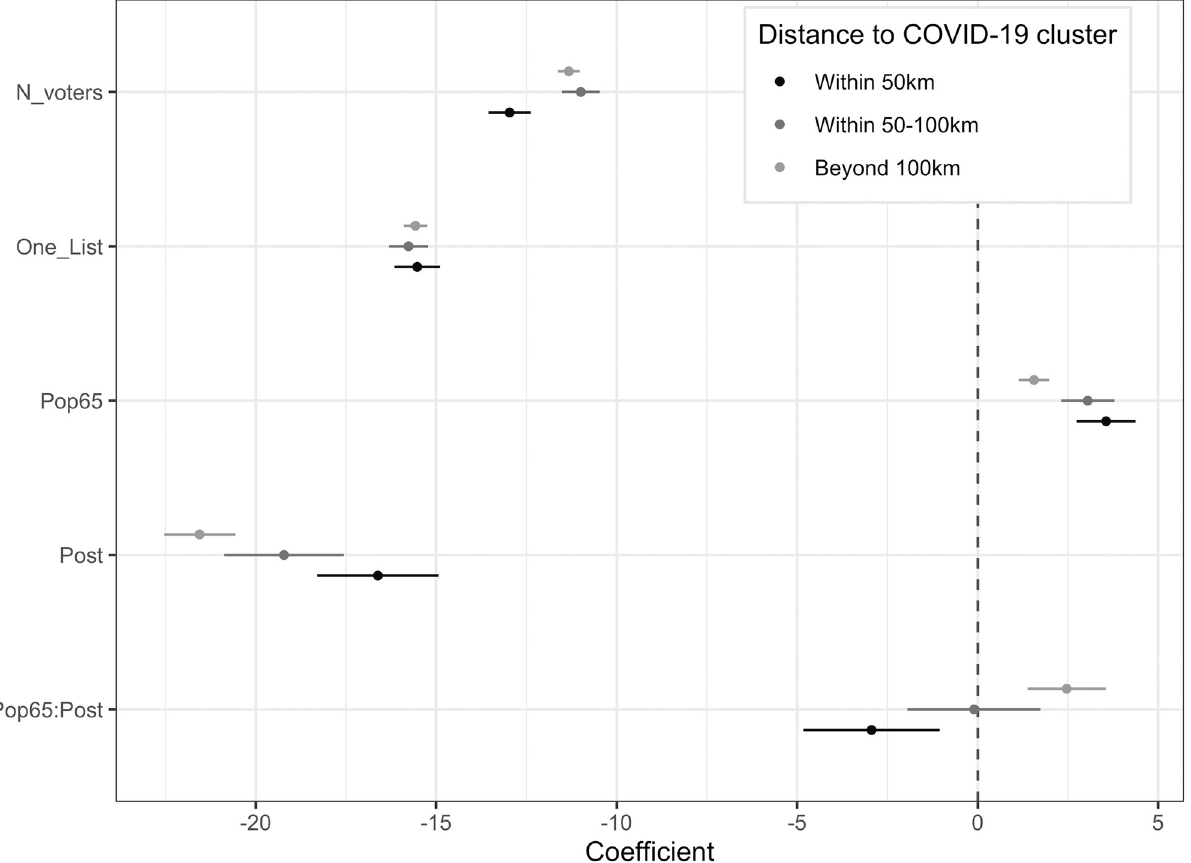
Fig 3. Determinants of turnout (breakdown by distance to nearest COVID-19